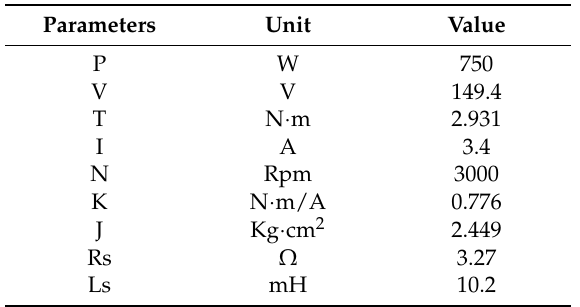
Table 1. Parameters of PMSM Sinano